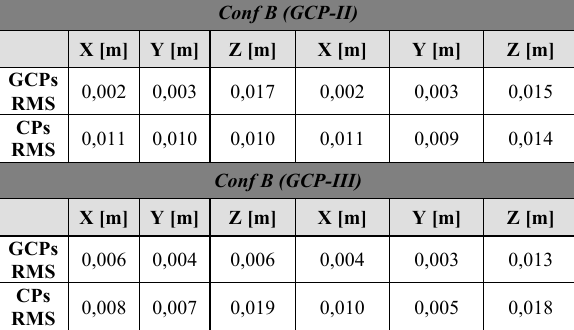
Table 2 Achieved RMS in Pix4D according